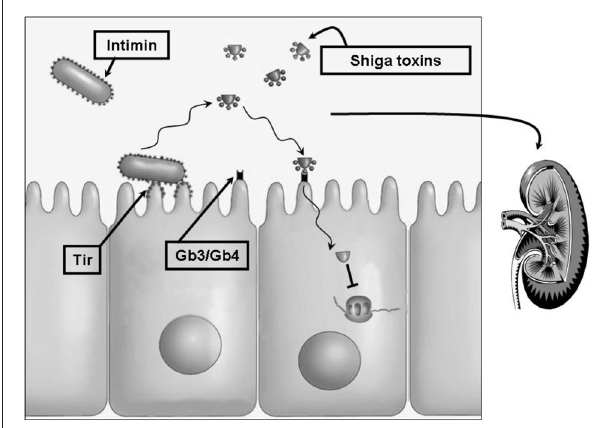
FIGURE 1 | The pathobiologic process of E. coli O157:H7. The complex process by which E. coli O157:H7 attaches to the intestinal mucosa starts by bacterial fimbrial attachment followed by translocation of the bacterial Tir protein into the host cell membrane. Tir serves as the receptor for the bacterial outer membrane attachment protein intimin. One or more types of Shiga toxins are released which then bind to their cellular receptors, the neutral glycolipids Gb3 and Gb4. Internalization and cellular activation of these toxins blocks ribosomal peptide elongation hence disrupting protein synthesis leading to cell death. Intestinal damage permits Shiga toxins and other bacterial factors to gain entrance to the circulation. These may reach multiple host tissues including the kidneys where damage to the microvasculature results in the potentially lethal hemolytic uremic syndrome. Treatment of this disease remains largely supportive with no widely accepted antibacterial or toxin-targeted regimen. Antibacterial agents are believed to result in bacterial lysis and release of stored toxins. One potential treatment method may rely on inhibition of toxin expression prior to administration of a bactericidal